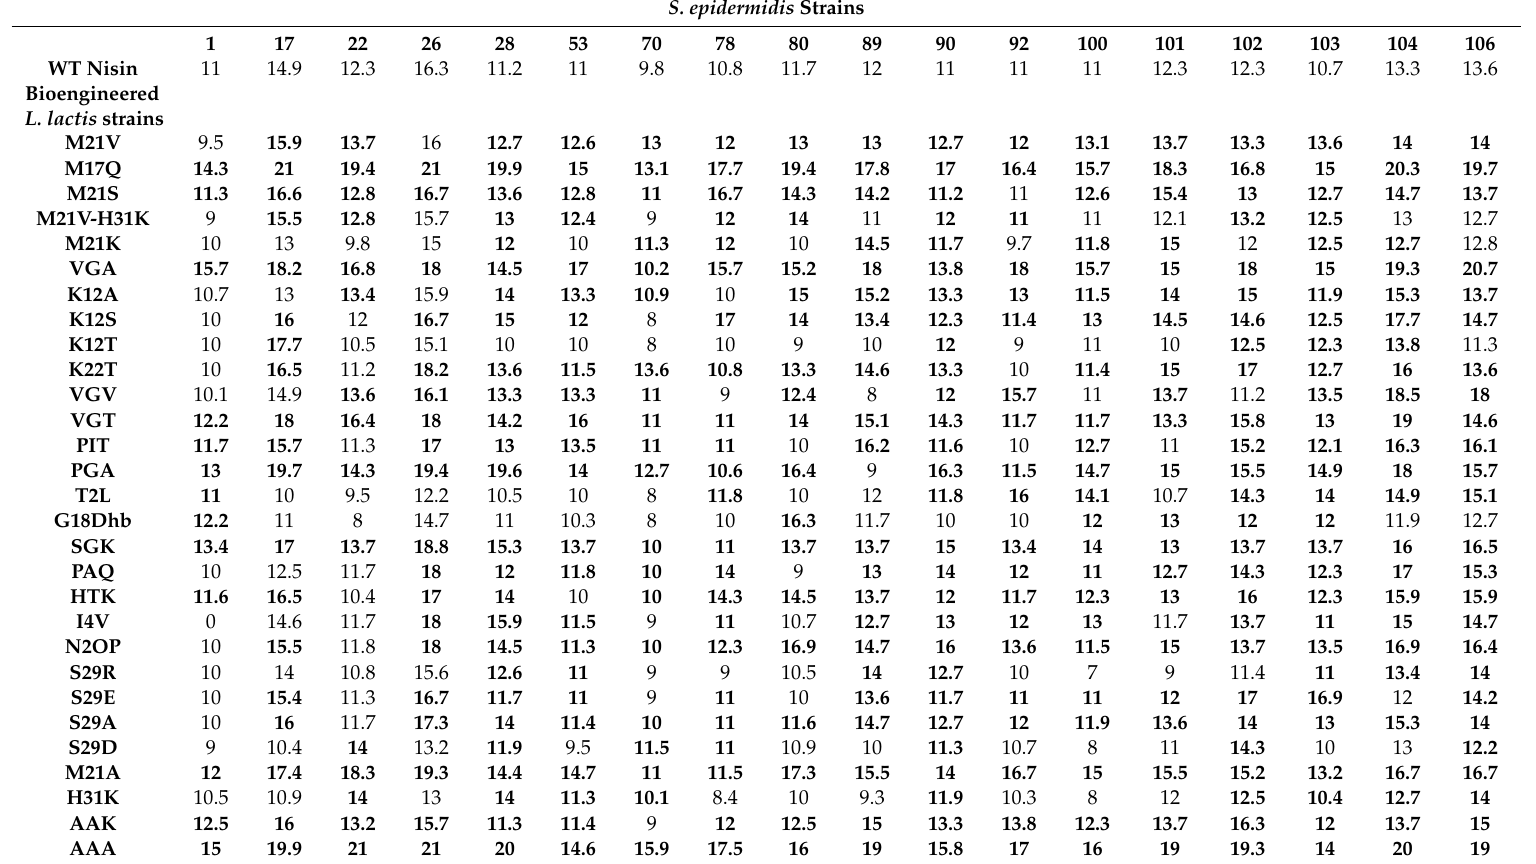
Table 1. Comparison of the antimicrobial activity of wildtype nisin A (WT) producing L. lactis strain to that of 29 bioengineered nisin-derivative producing L. lactis strains through an agar based deferred antagonism assay. Each peptide producer was tested against 18 S. epidermidis strains in triplicate. The figures in the table are the results obtained for 1 repeat and are representative of the results obtained for all three biological repeats. Zone sizes are presented in millimeters. Values highlighted in bold indicate that the representative zone obtained from the bioengineered strain is larger than the zone obtained from the wildtype producer against that specific S. epidermidis